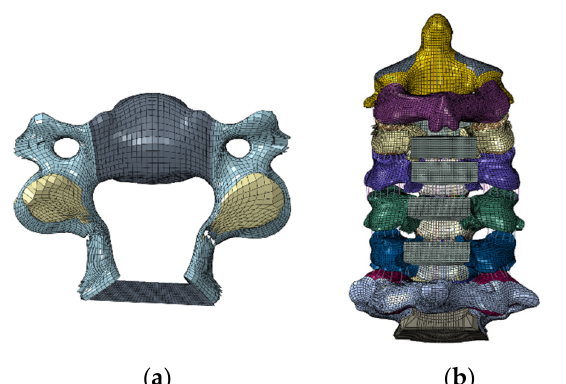
Figure 2. ( a ) Axial view of double-door laminoplasty at C4, ( b ) C2–C7 model with laminoplasty from C3–C6.